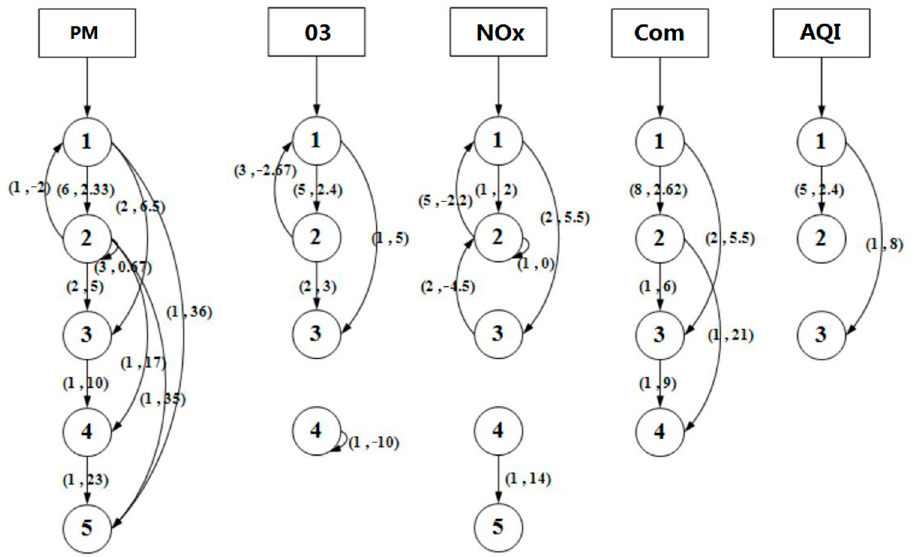
Figure 4. The numbers in the circles represent the number of published papers that use a certain research method for the prediction of the pollutant shown at the top of the column. The arrows coupled with two numbers in parentheses represent the change trend of the number of published studies from 2000–2009 to 2010–2018; the first number represents the number of prediction methods with this type of change and the second number represents the difference between the average number of papers published in 2000–2009 and 2010–2018.